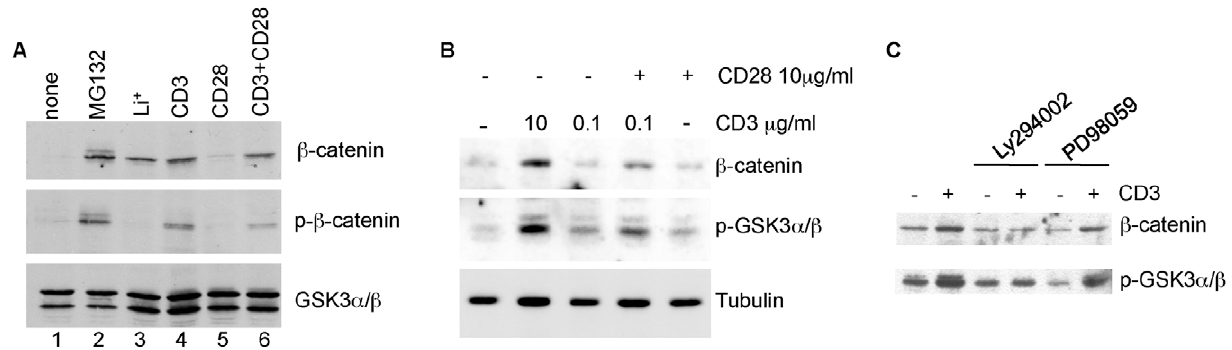
Figure 5. PI3K regulates the expression of b -catenin downstream of TCR signalling. (A) T cells were left untreated or were incubated for 18 hours with the proteasome inhibitor MG132, 20 mM LiCl, plate bound anti-CD3 (10 m g/ml), plate bound anti-CD28 (10 m g/ml), plate bound anti- CD3 plus anti-CD28 (10 m g/ml each). Total cell lysates were used for Western blotting with anti- b -catenin, anti-phospho- b -catenin and anti-GSK3 ab . (B) T cells were stimulated for 18 hours with two different concentrations of plate-bound anti-CD3 in the absence or presence of anti-CD28. Total cell lysates were analysed by Western blot with anti- b -catenin, anti-p-GSK3 ab and anti-tubulin. This experiment was performed twice with similar results. (C) T cells were pre-treated with the PI3K inhibitor Ly294002 (50 m M) or the MEK inhibitor PD98059 (50 m M) for 1 hour prior to 18 hours stimulation with plate bound anti-CD3 in the presence of these inhibitors. Total cell lysates were immunoblotted with indicated antibodies.